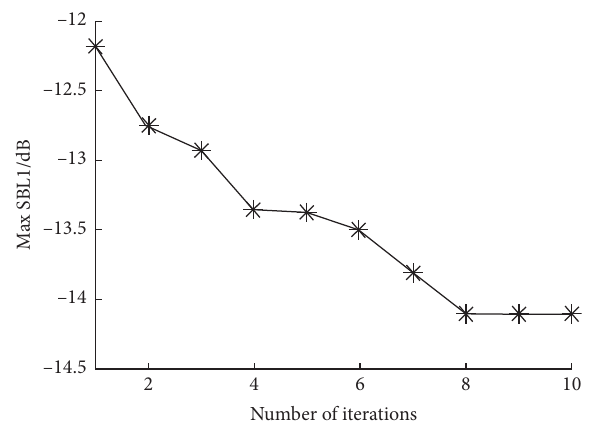
Figure 14: Convergence curve of the second